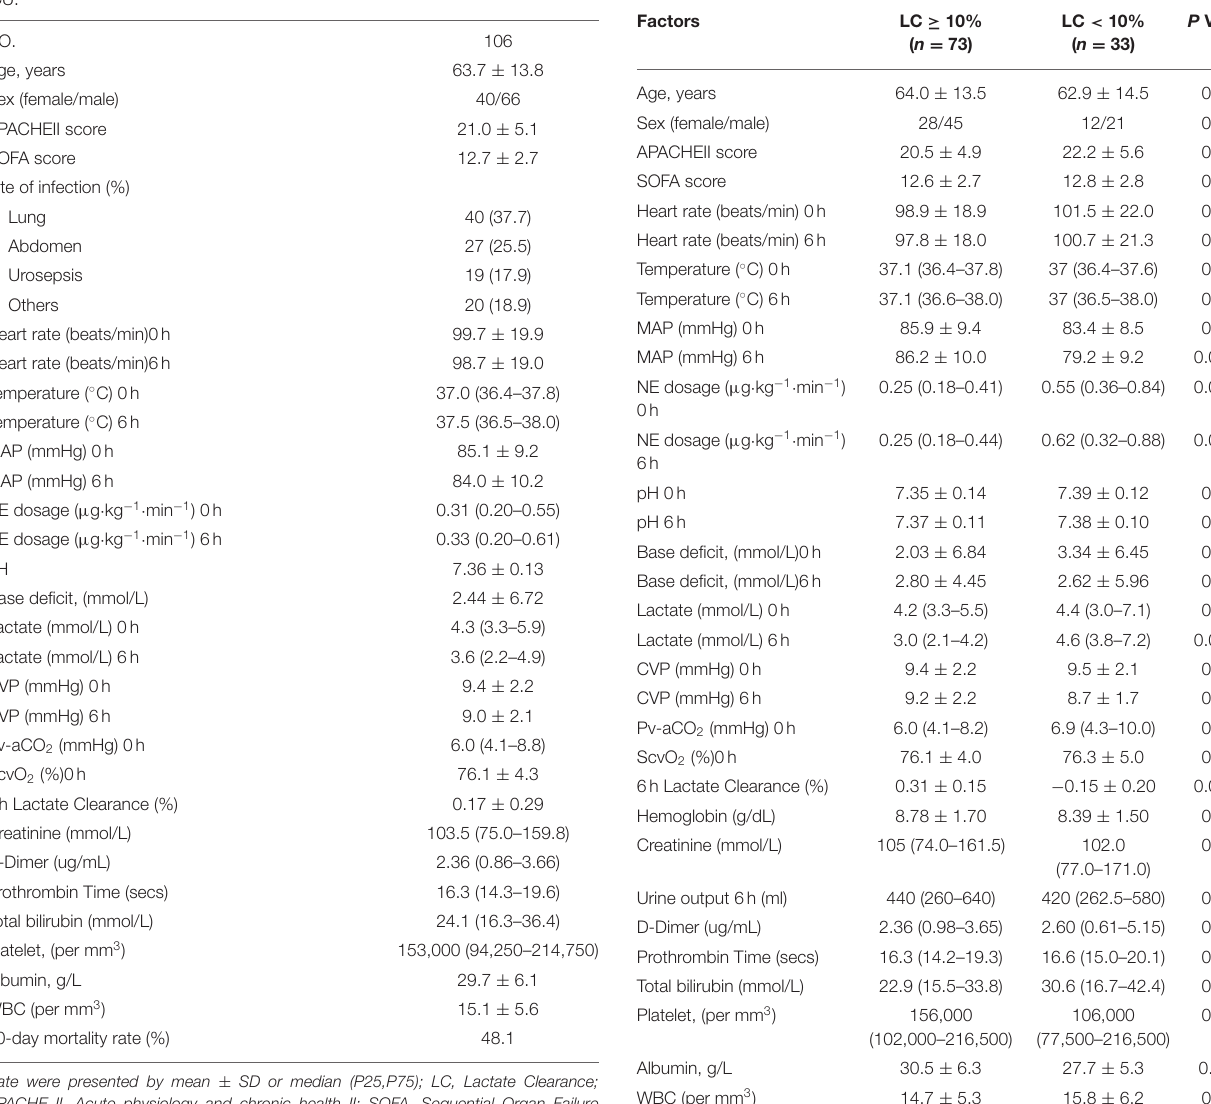
TABLE 2 | Univariate comparisons between LC ≥ 10% and LC < 10%